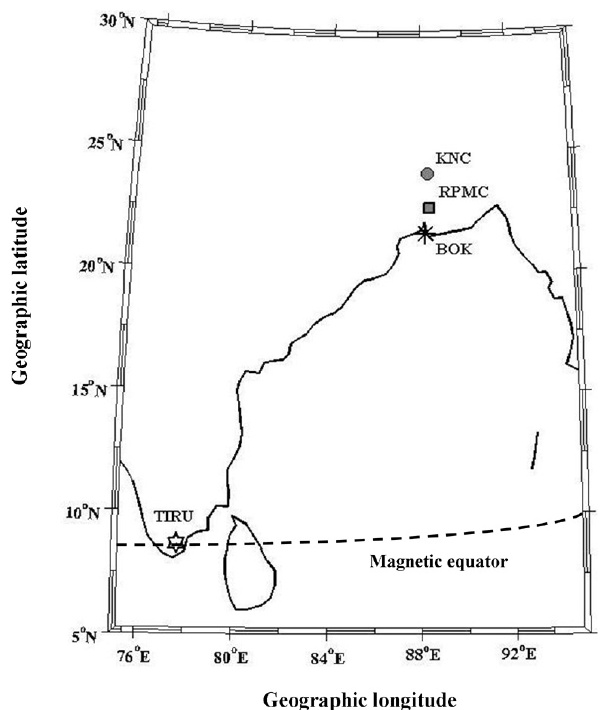
Fig. 1. Geographic locations of three observing stations: BOK (21.6 ◦ N, 88.2 ◦ E), RPMC (22.66 ◦ N, 88.4 ◦ E) and KNC (24.1 ◦ N, 88.3 ◦ E) and the ionosonde centre at TIRUNELVELI (TIRU) (8.73 ◦ N, 77.7 ◦ E). Dotted line indicates the average position of magnetic equator over the observation